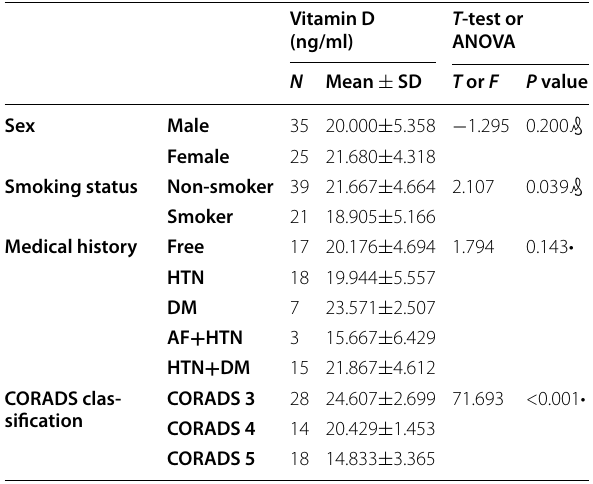
Table 3 Relation between vitamin D and sex, special habits, medical history ,and CORADS classification